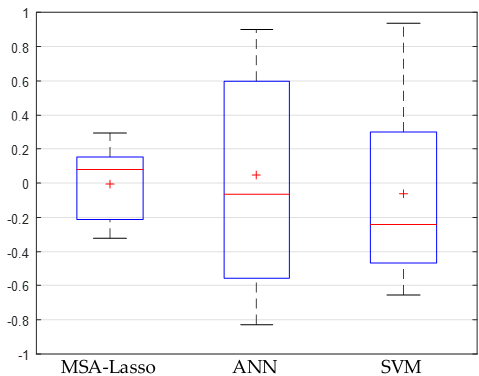
Figure 6. Boxplot of relative errors in the base load condition of the IEEE 14-bus system.